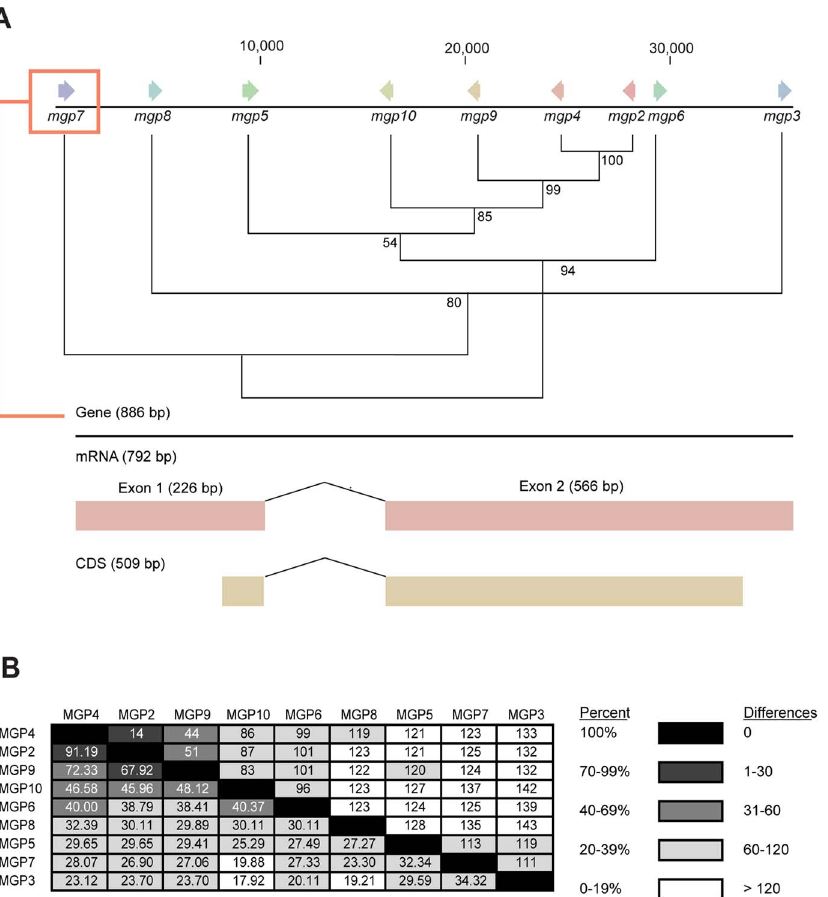
Figure 8. Genome localization of Glossinamorsitans and mgp2–10 phylogeny of genes for novel Glossinamorsitansmorsitans milk gland proteins. (A) Initial sequence alignment was completed using ClustalX [23,124] and formatted with BioEdit [23]. Evolutionary analyses were conducted in MEGA4/5 [25,26,125] and displayed as a neighbor-joining tree. (B) Percent amino acid similarity (Bottom) and amino acid differences (Top) between MGP2–10.